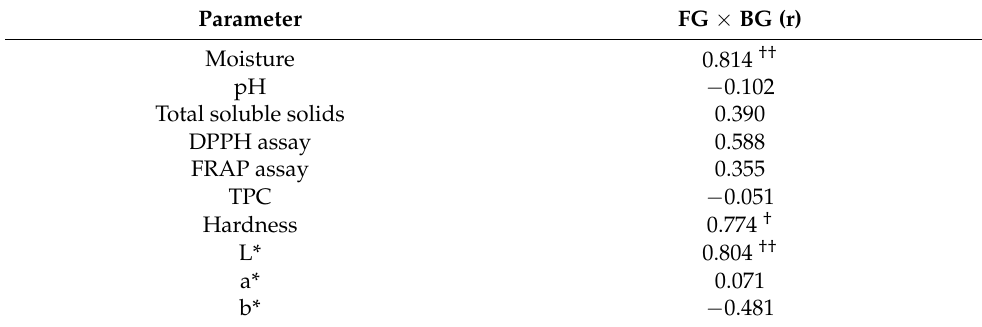
Table 5. Correlation (r) between observed parameters of fresh garlic (FG) and black garlic